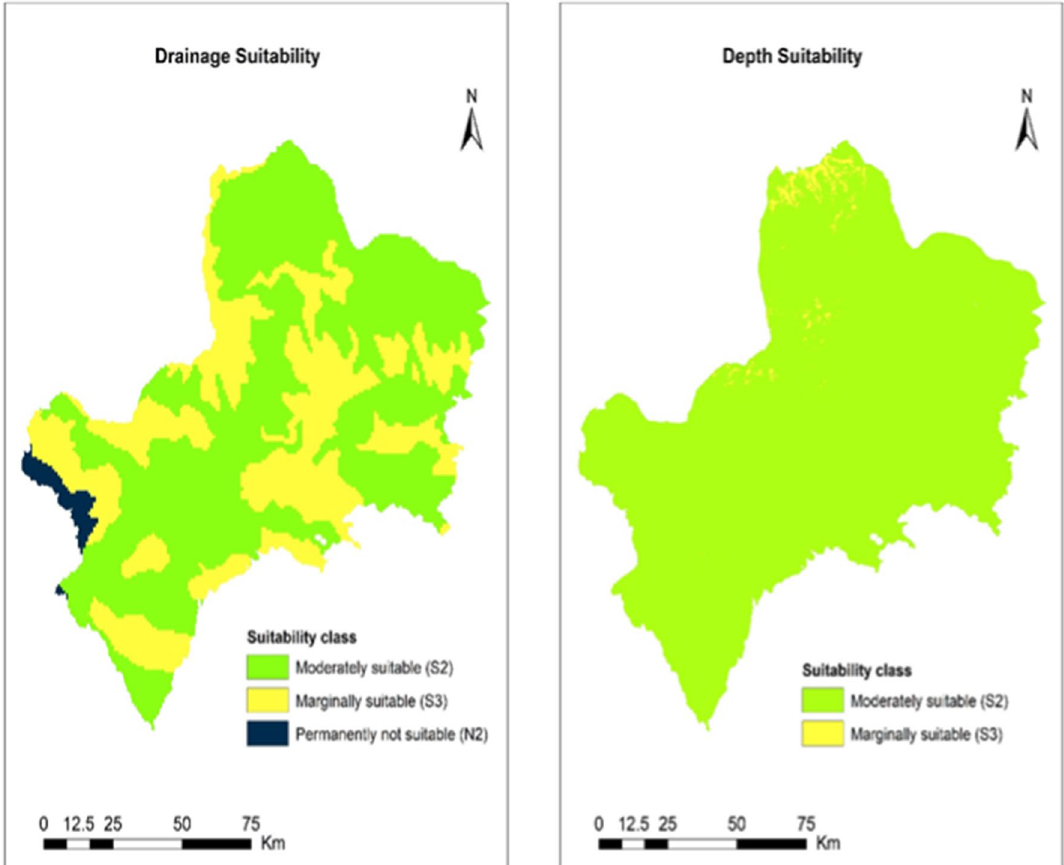
Fig. 3 Soil drainage and soil depth suitability